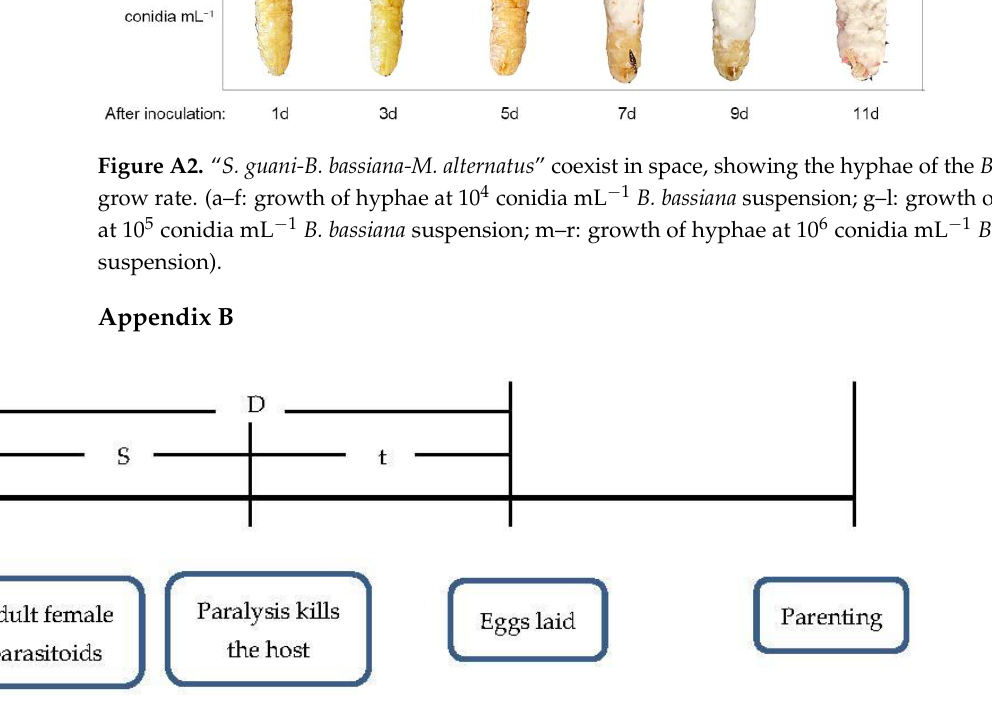
Figure A3. Exploded view of the model-the mortality effect of S. guani on the host under B. bassiana stress ’ s supplementary mate.